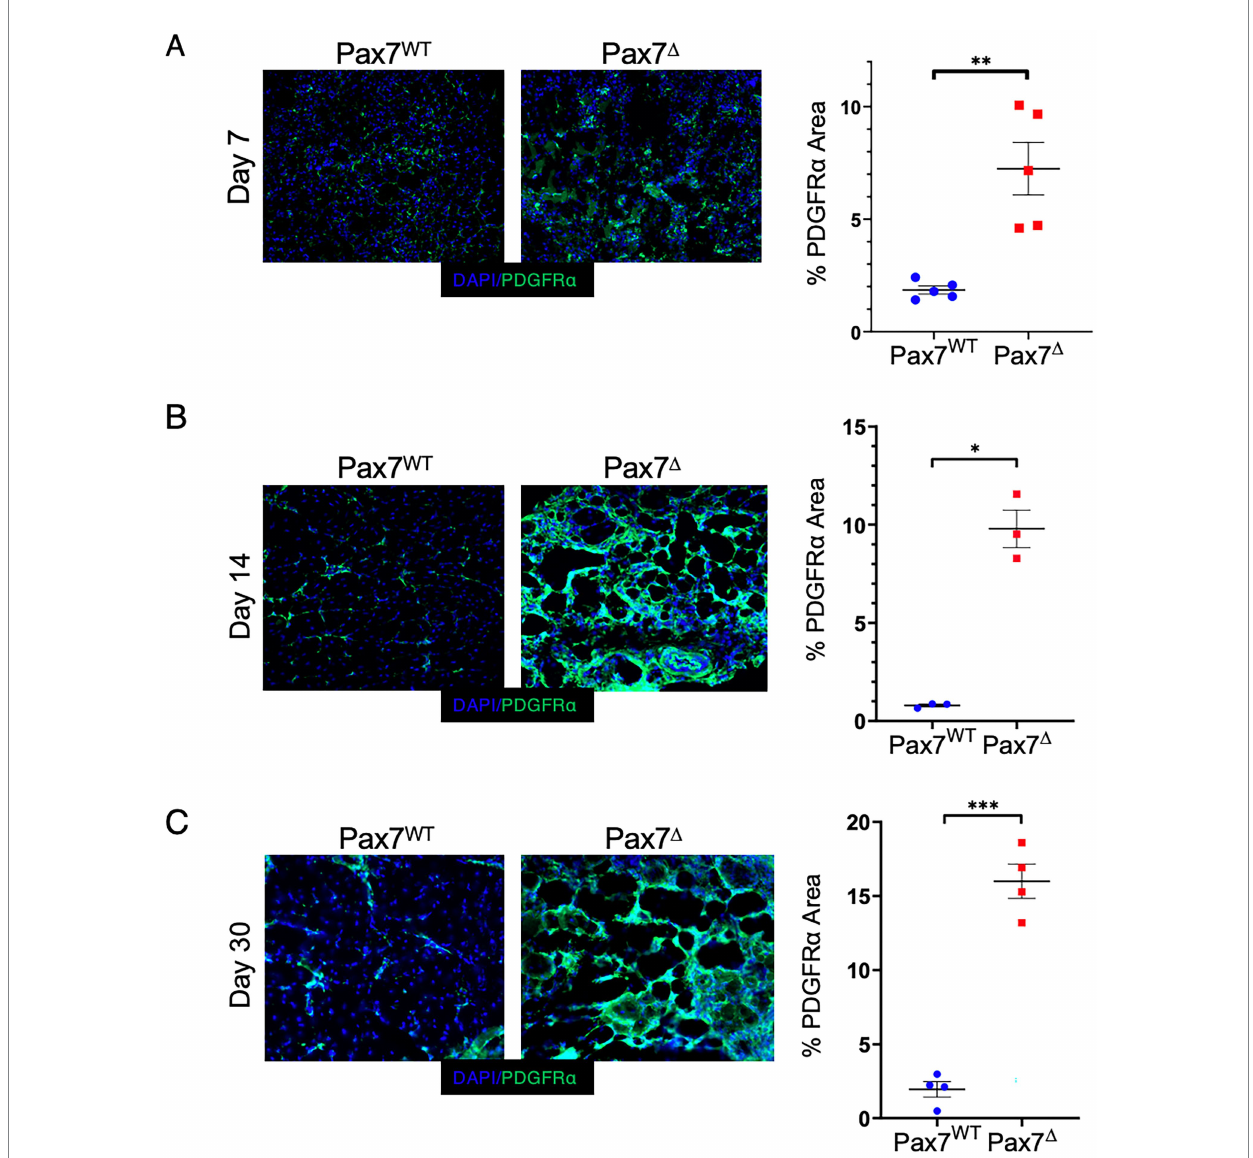
FIGURE 6 Ablation of Pax7 + MPCs in mice results in a significant increase in FAPs in skeletal muscle following ischemia. (A-C) PDGFR α staining of the ischemic TA muscle demonstrated significantly increased FAP staining in Pax7 Δ mice compared to Pax7 WT 7 days (A), 14 days (B) , and 30 days (C) after HLI surgery ( n = 3–5 per group). Scale bars = 1 mm. All data shown are means +/-SEM. * p < 0.05; ** p < 0.01; *** p < 0.001 by 2-sided t